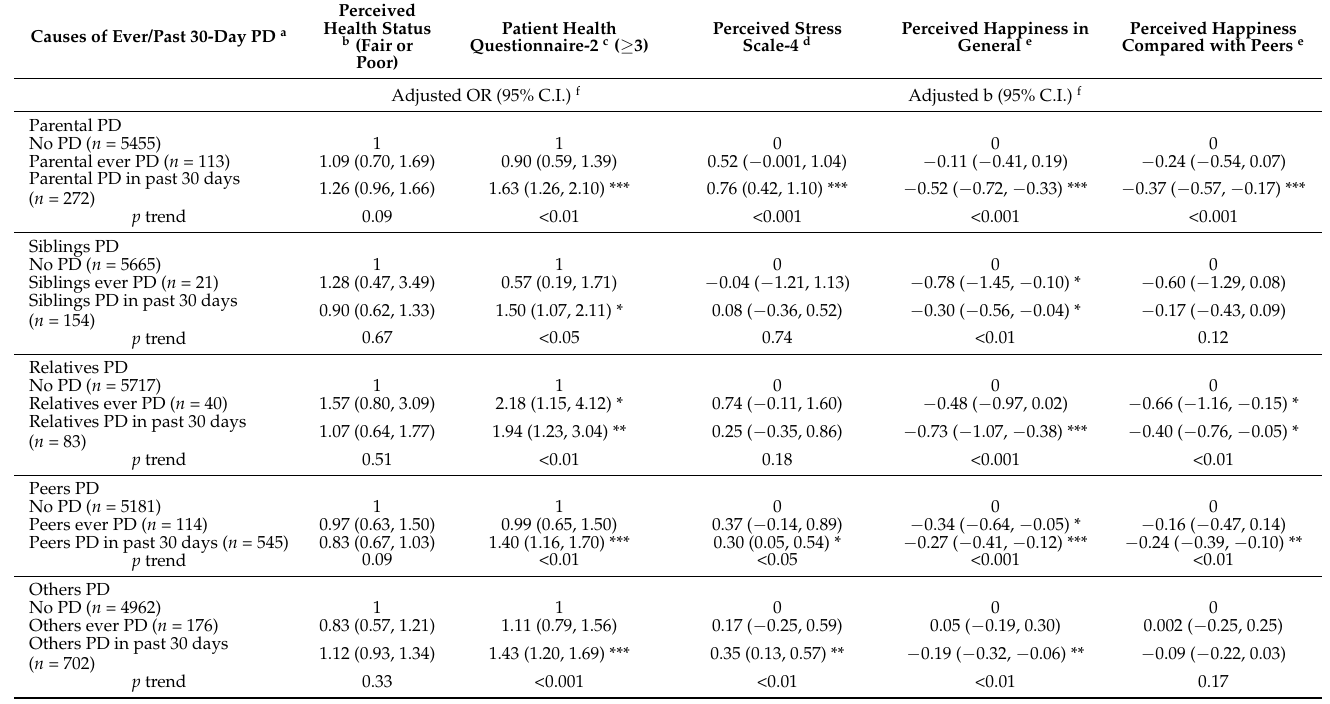
Table 3. Associations of causes of ever and past 30-day passive drinking with perceived health status, mental health status, and perceived happiness in 5840